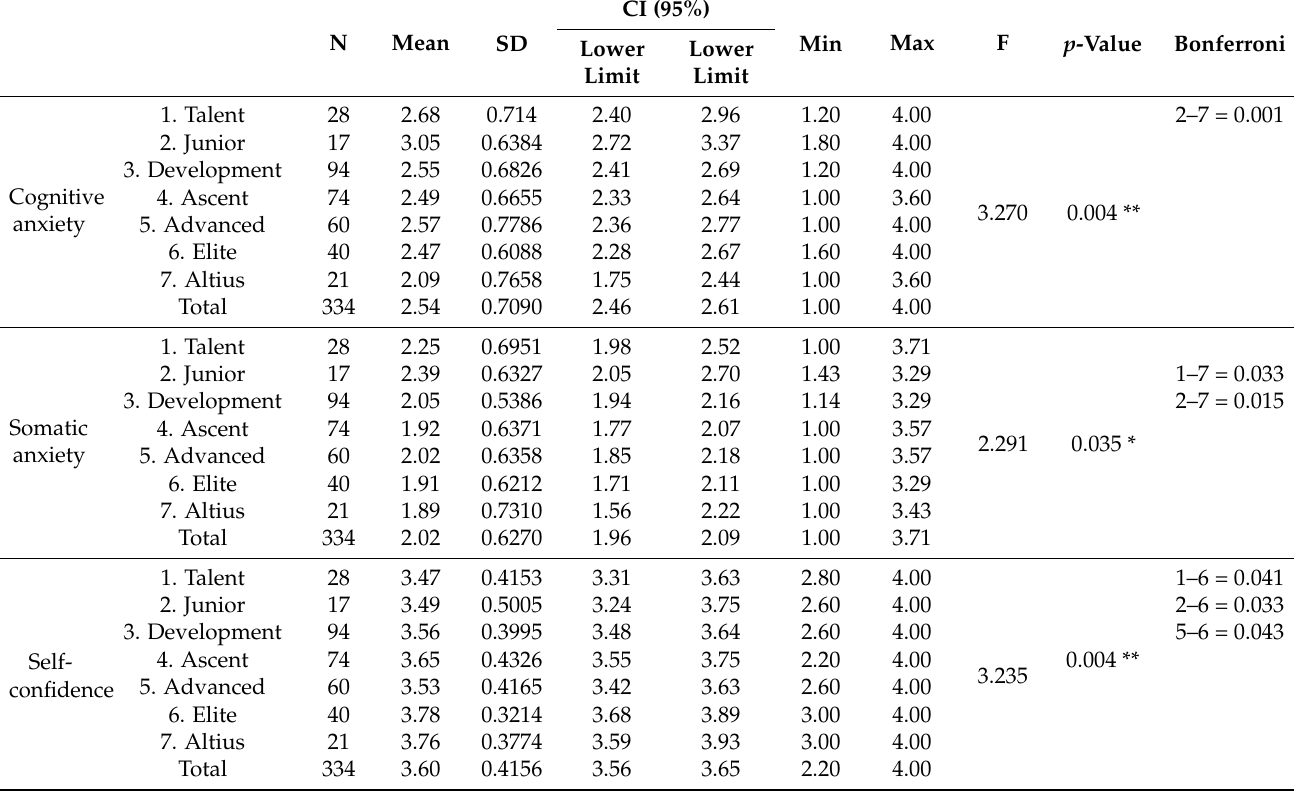
Table 9. Differences by athlete categories.